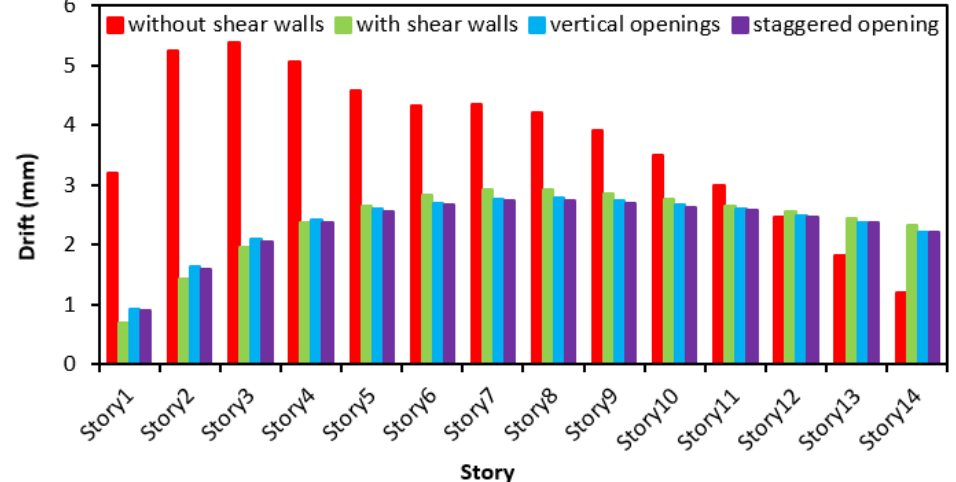
Figure 18. Story drift of the models, time history analysis, Y-direction. The results show that the story drift increases from the second story and onwards. It gradually grew and has a tendency to fall back to the top story. The model with a vertical opening and staggered opening shear wall indicates more drift value compared to the shear wall without an opening. The building without shear walls shows a high drift value. The same findings have been found in the published literature by Marius [29].